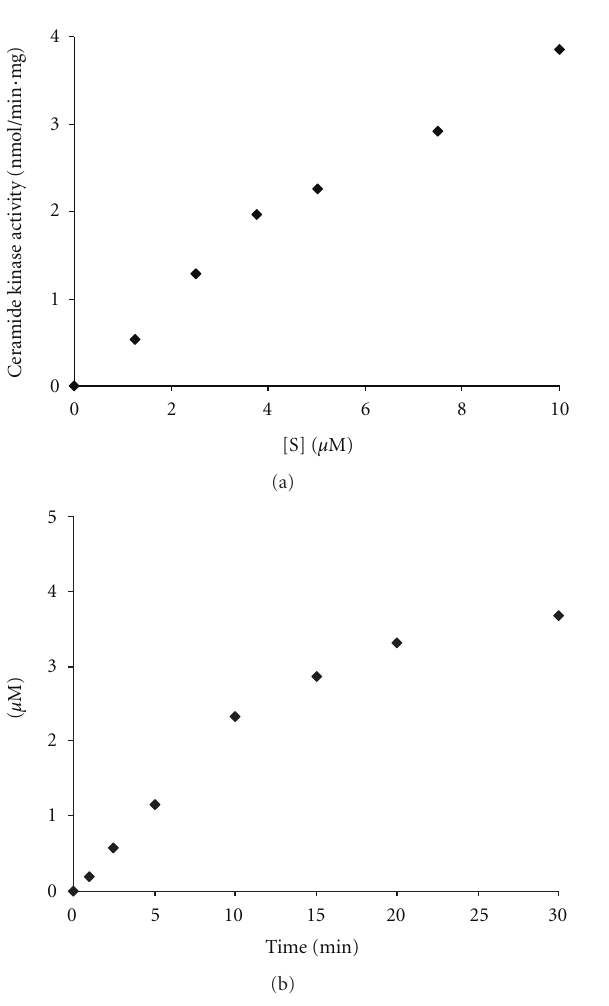
Figure 4: Substrate and time dependence of the kinase reaction. Recombinant bacterially expressed Hs CERK was incubated with the indicated concentration of NBD-C 6 -Cer (a) or 5 μ M (b) in the presence of 1 mM ATP at 37 ◦ C. The reaction was stopped at 10min (a) or the indicated time periods (b) by addition of methanol and the mixture was applied to an NH 2 -SPE column. The reaction product NBD-C 6 -Cer-1-P was quantified based on fluorescence intensity of the column eluate and converted into nmol or μ M, based on a calibration curve.